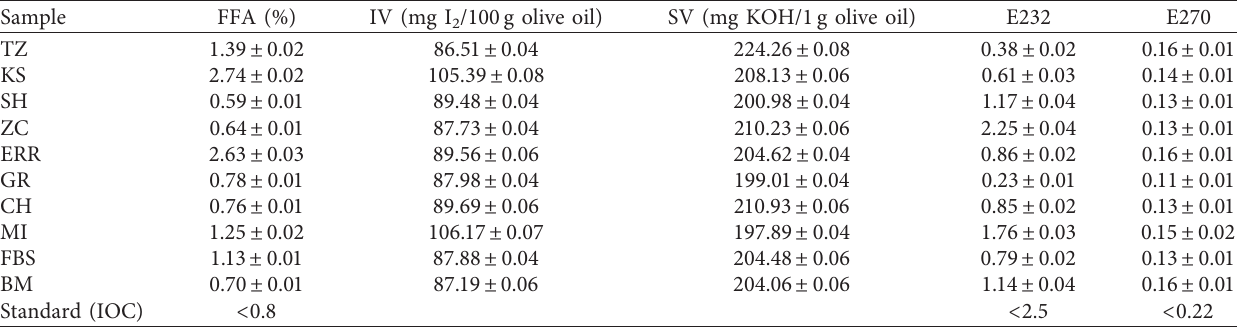
Table 2: Quality parameters of the studied olive oils.